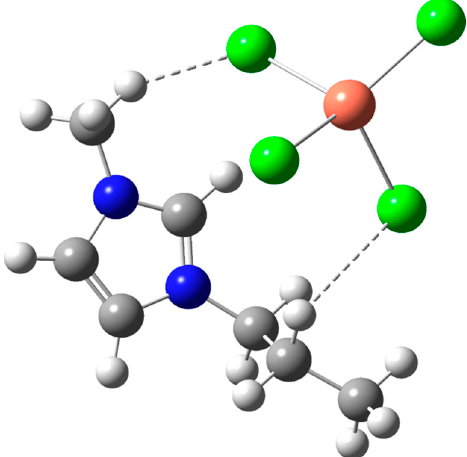
Figure 2. The structure of the [CuCl 4 ] 2 − complex adsorbed on to the cation [PrMIm] + , as calculated using the computational chemistry software, Gaussian 16. Here the blue, the smallest light grey, dark grey, brick red in the upper right corner, and green balls represent N, H, C, Cu, and Cl atoms, respectively.